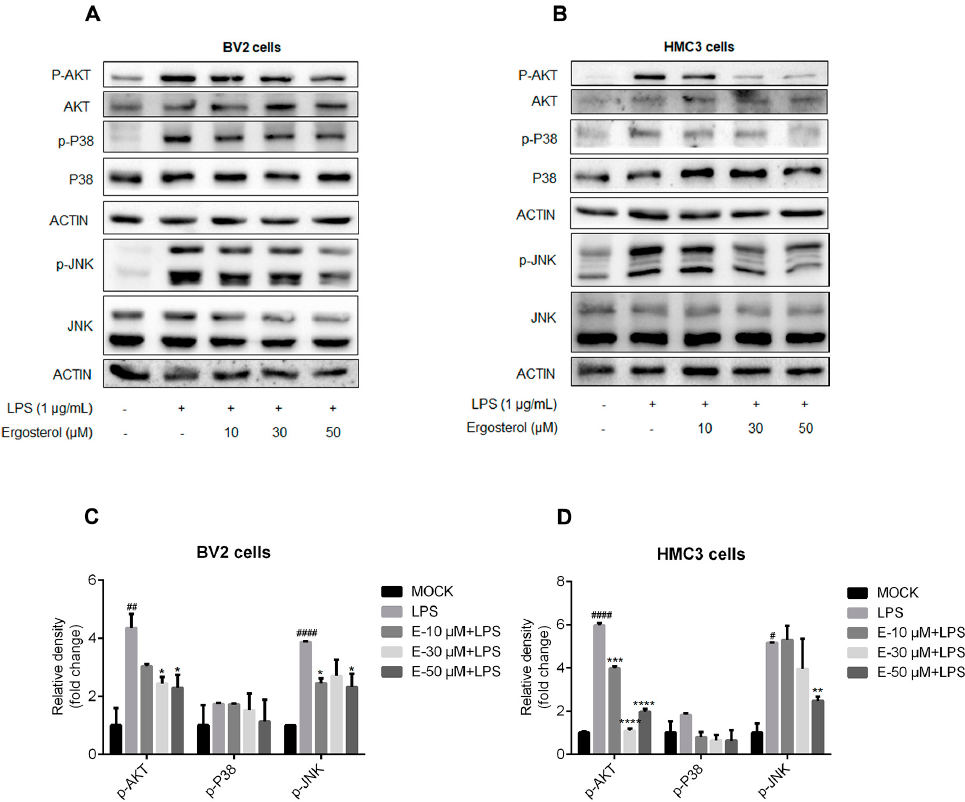
Figure 3. Ergosterol suppresses the activation of the MAPK and AKT signaling pathways in BV2 and HMC3 cells stimulated by LPS. ( A , C ) BV2 microglial cells were pretreated for 2.5 h at the indicated concentration of Ergosterol and then stimulated by LPS (1 µ g/mL) for 30 min. The protein levels of P38, p-P38, JNK, p-JNK, AKT, and p-AKT were determined by Western blot in the BV2 cells. Actin was used as a housekeeping control. ( B , D ) Similar experiments were performed with the HMC3 cells. All data are mean ± SEM of triplicate values. Statistical significance was analyzed using one-way ANOVA and t test. # Significantly different from the control; * significantly different from the LPS-treated group. Significance: # p < 0.05, ## p < 0.01, #### p < 0.0001, * p < 0.05, ** p <